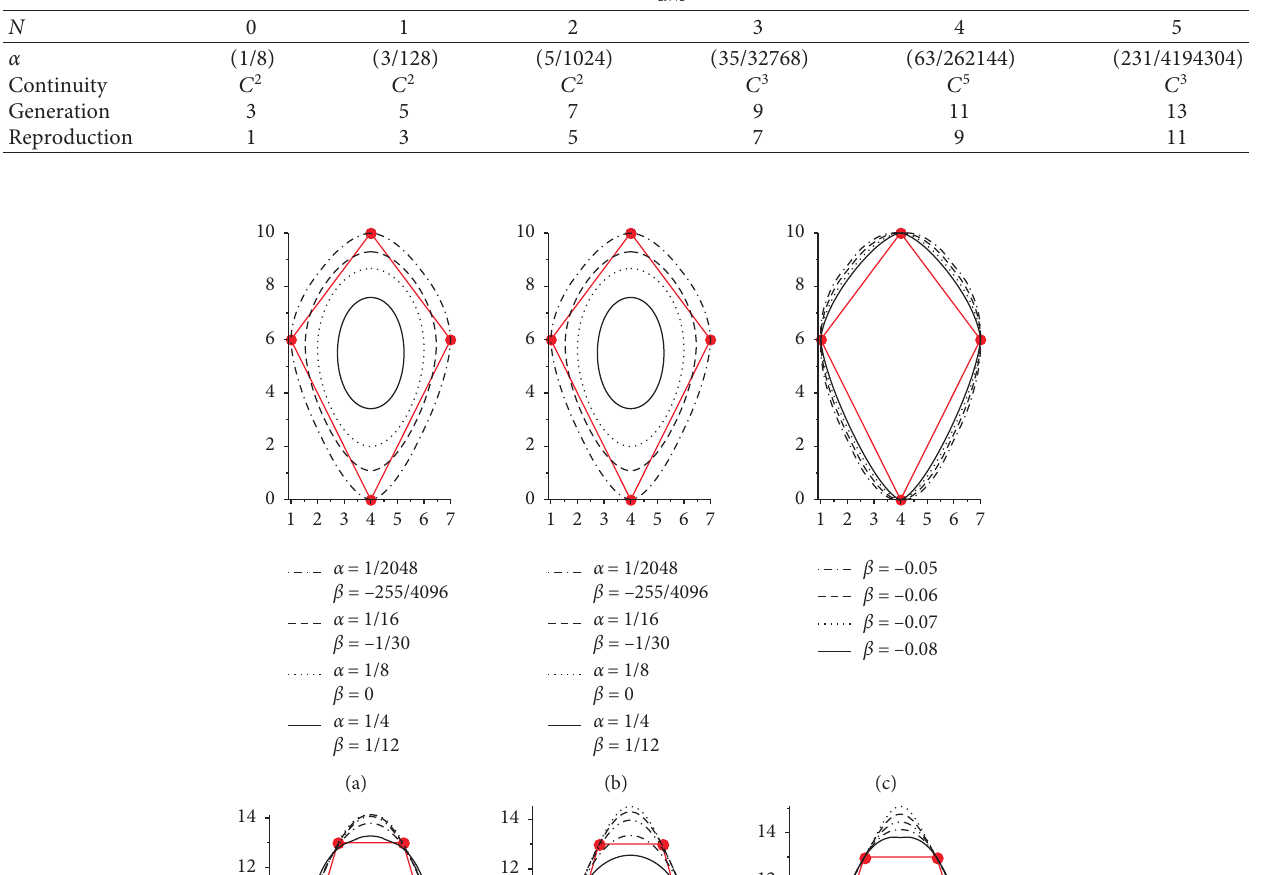
a 2 N + 2 for specific values of α